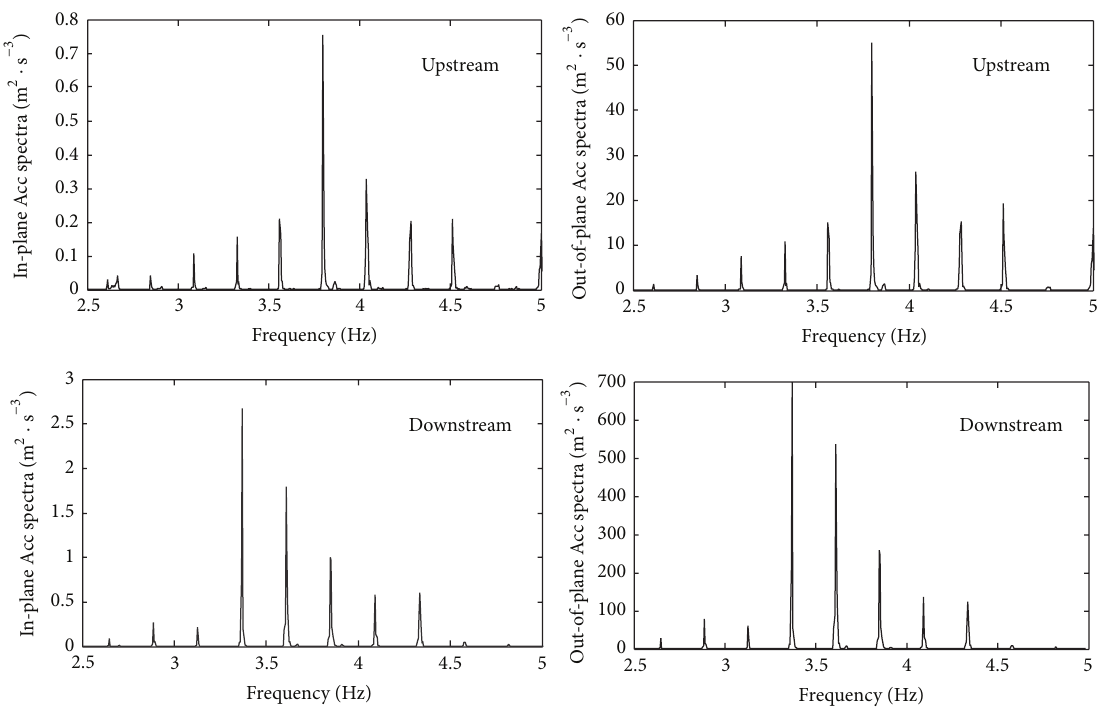
Figure 19: Spectra of stay cable acceleration